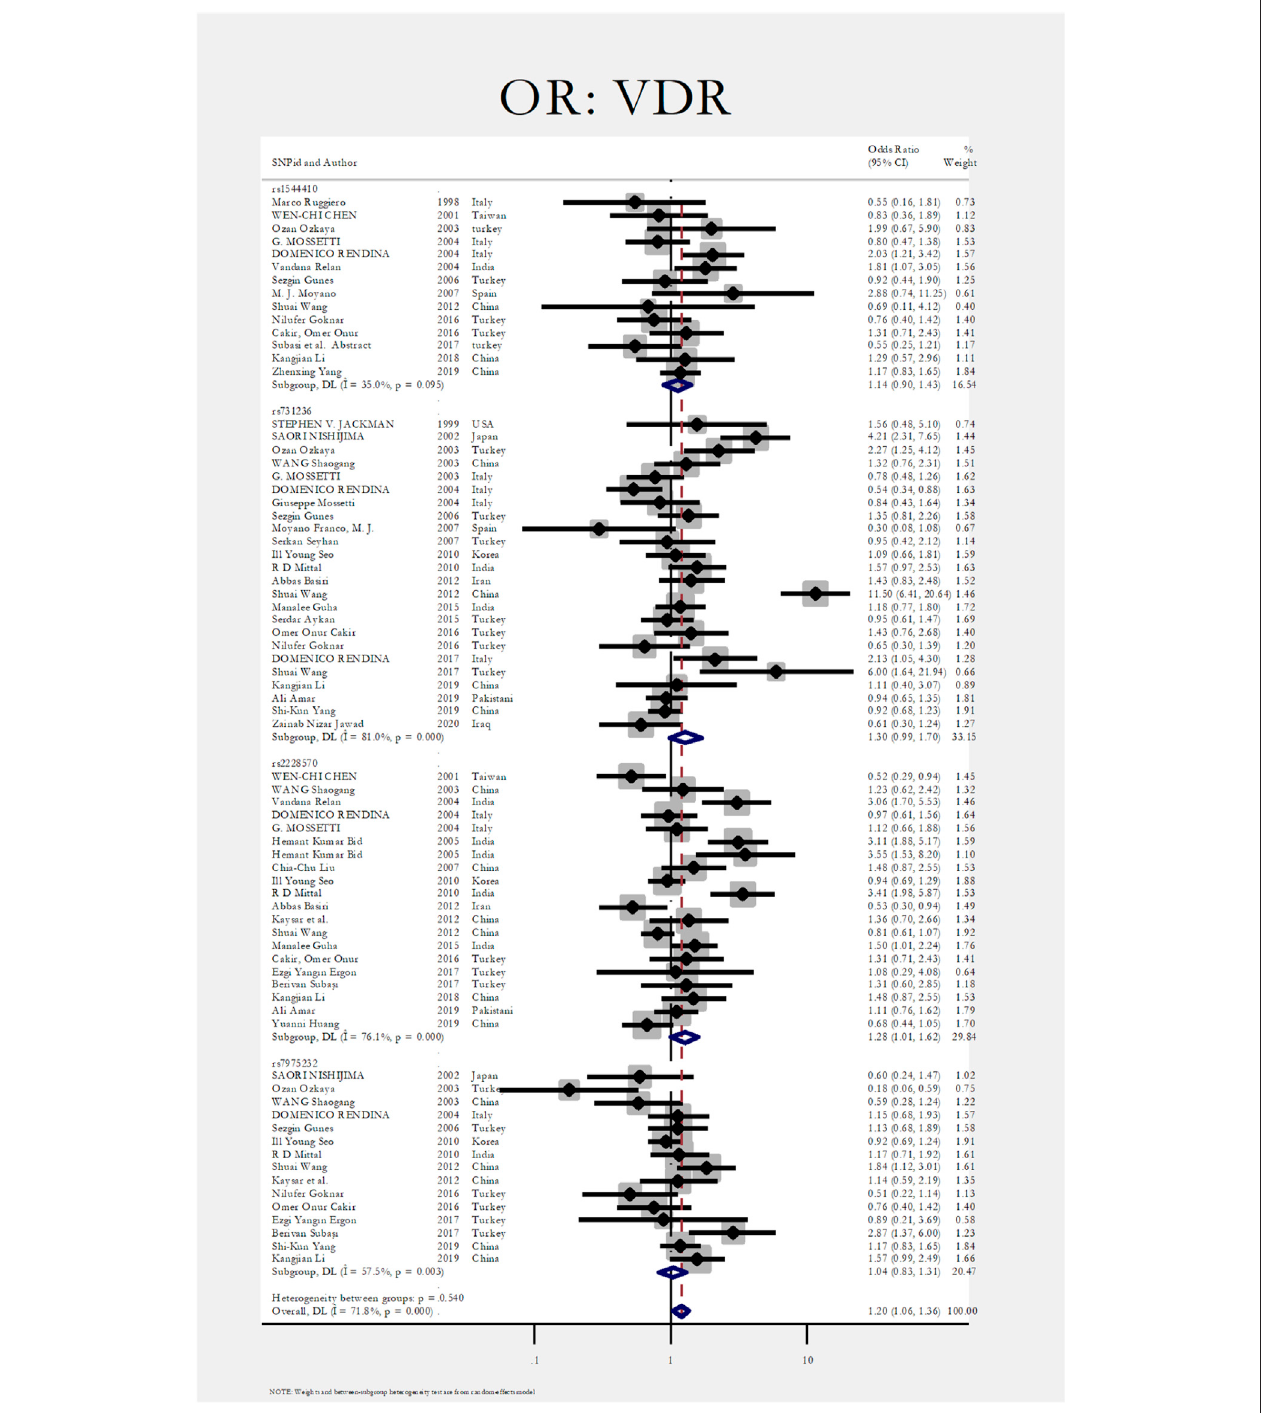
FIGURE 4 | Subgroup analysis for VDR, by SNP